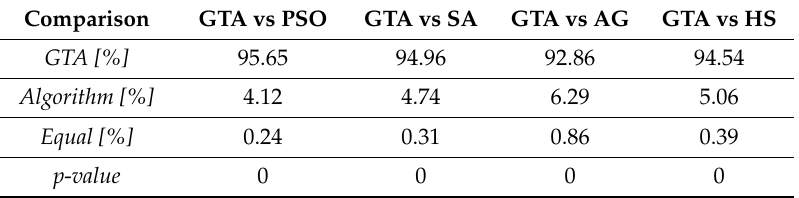
Table 4. Comparison of results between GTA and classical algorithms.